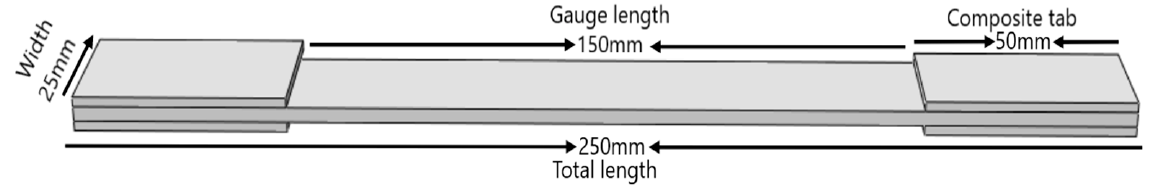
Figure 6. Schematic diagram of the tensile test specimen.